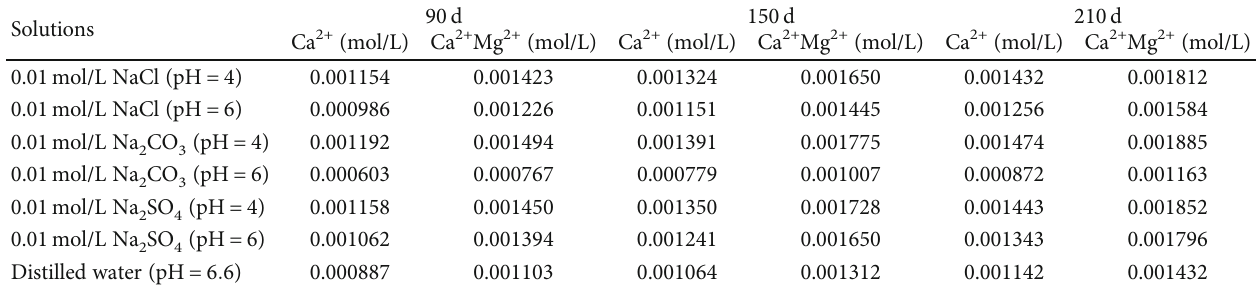
Table 7: Concentrations of Ca 2+ and Mg 2+ in static